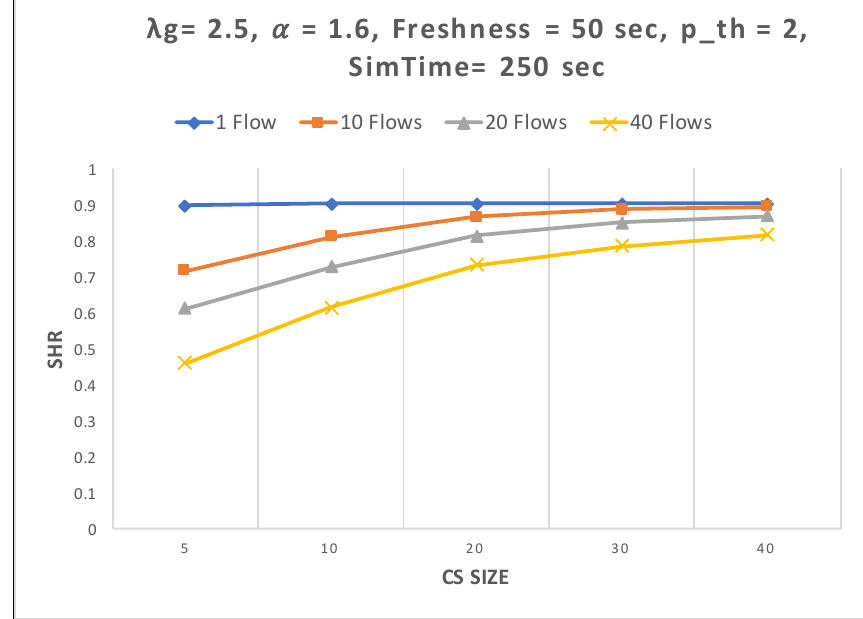
Figure 5. SHR as s a function of the Content Store size.